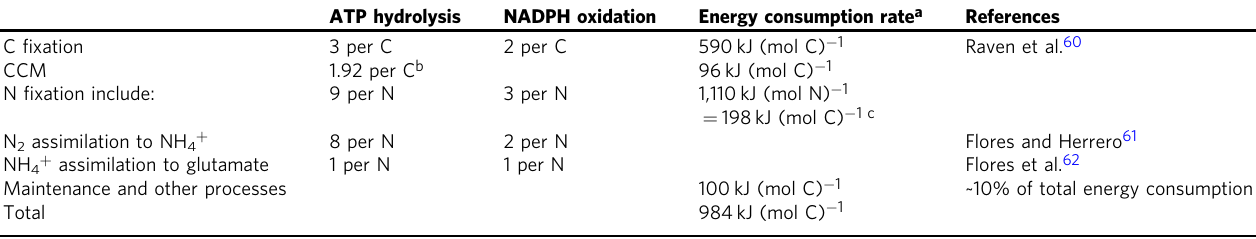
Table 2 Energy consumption rates of Trichodesmium cellular processes under ambient condition ATP